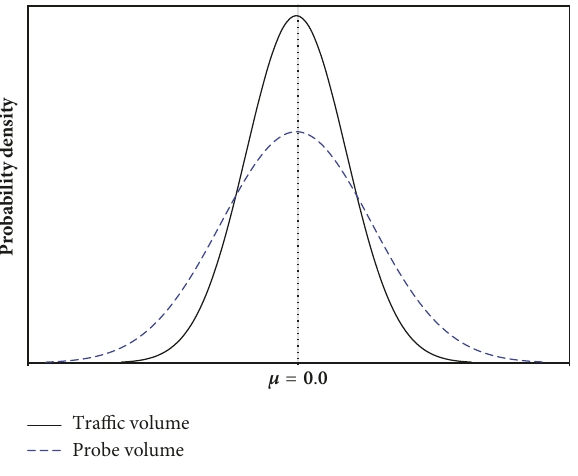
Figure 1: Distributions of relative